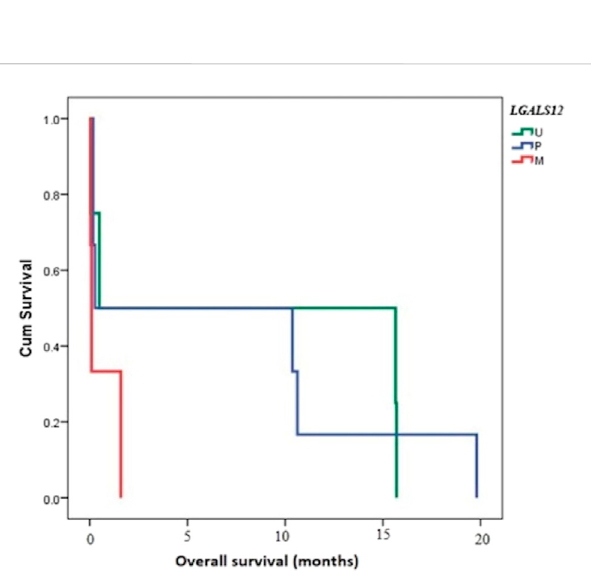
FIGURE 4 Overall survival (OS) and its relation to methylation pattern of LGALS12 . Abbreviations: M (methylated); P (partially methylated), U (unmethylated), BM (Bone marrow); PB (Peripheral blood). FIGURE 5